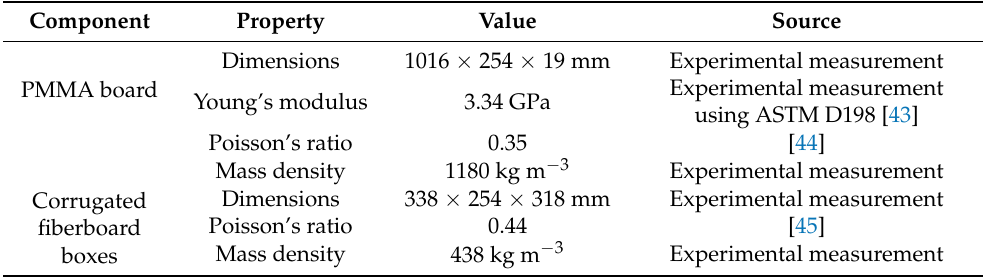
Table 1. Material properties for the unit load analogue components used for the model